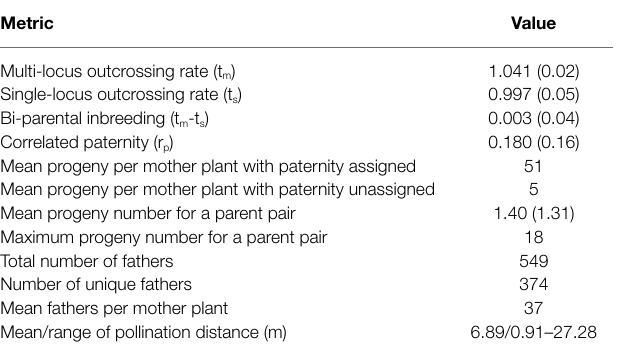
TABLE 1 | Summary of mating pattern and pollen diversity and parentage analysis. Values in parenthesis are standard deviations.